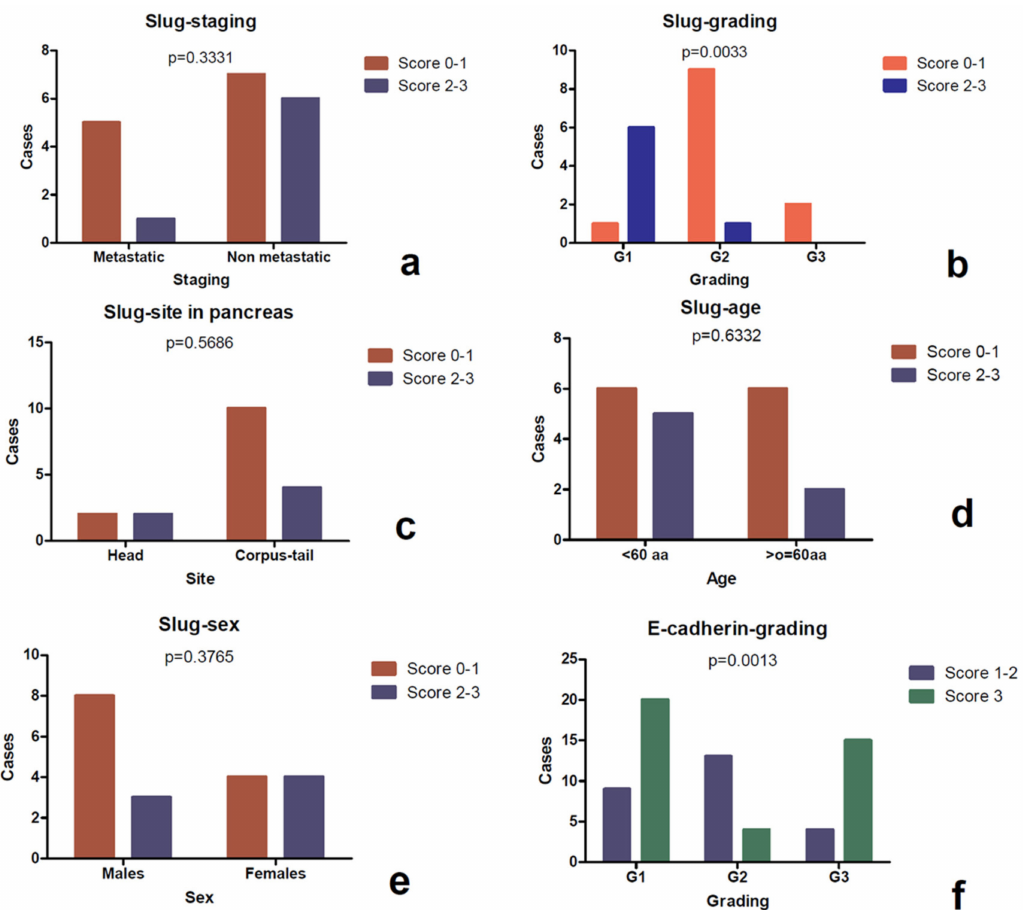
Figure 6. Study of association between the Slug score and the clinico-pathological parameters assessed by the Fisher’s exact test. It was observed that a higher Slug score (score 2–3) was correlated with a lower grading ( b ), as well as E-cadherin loss resulted was to be statistically correlated to higher grading ( f ). Slug was not associated with stageing ( a ), pancreatic regions ( c ), age ( d ) and sex ( e